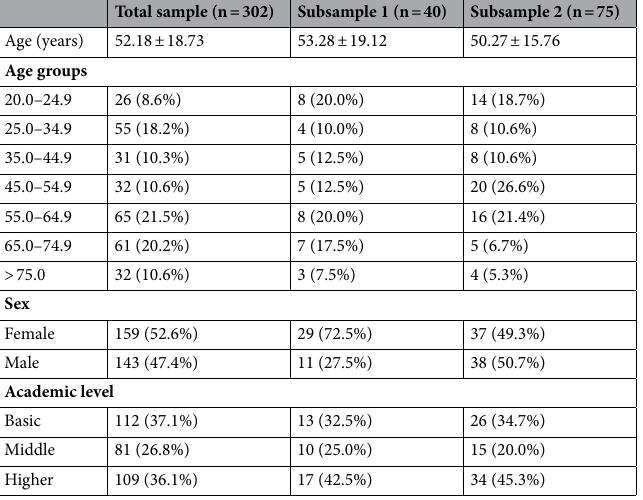
Table 4. Sociodemographic characteristics of the sample and each of the two subgroups. Values are presented as mean ± standard deviation or frequencies and percentages between